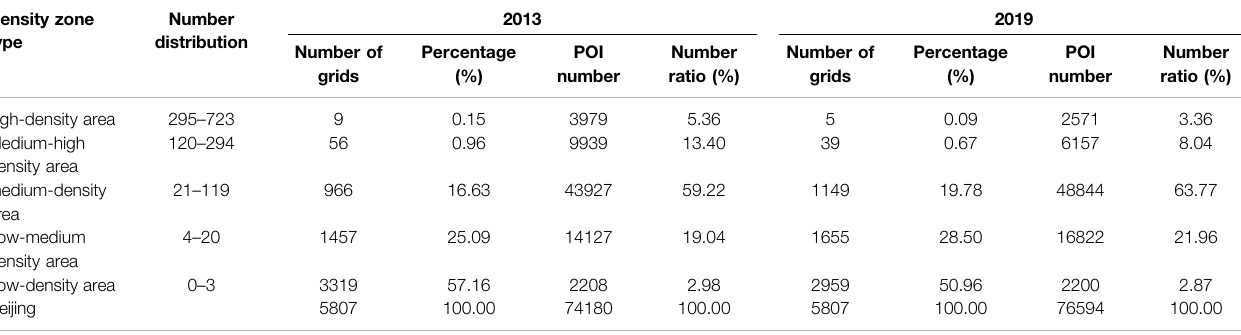
TABLE 3 | Statistics of number of fi shing nets and POI points in each density area.